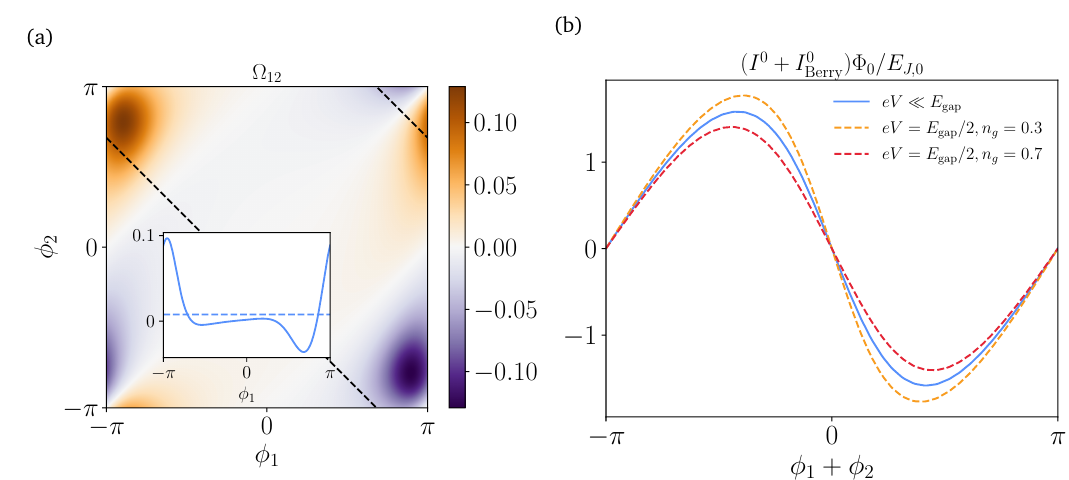
Figure 4: (a) Berry curvature of the ground state of the circuit in Fig. 1(b) = E / 2, E = E / 4, E = E = 0.7. The inset shows with E and n J ,1 J ,0 J ,2 J ,0 C J ,0 g + φ = − 1 (black dashed line). Because the average (blue a cut along φ 1 2 dashed line) is finite, the quartet supercurrent has a geometric contribution. (b) Quartet current-phase relation of the circuit in (a) with geometric correc- tions. The scale of the voltage is set by the minimum spectral gap E over gap the Brillouin zone. Reflecting n about 0.5 flips the sign of the Berry curvature g and hence of the geometric component of the